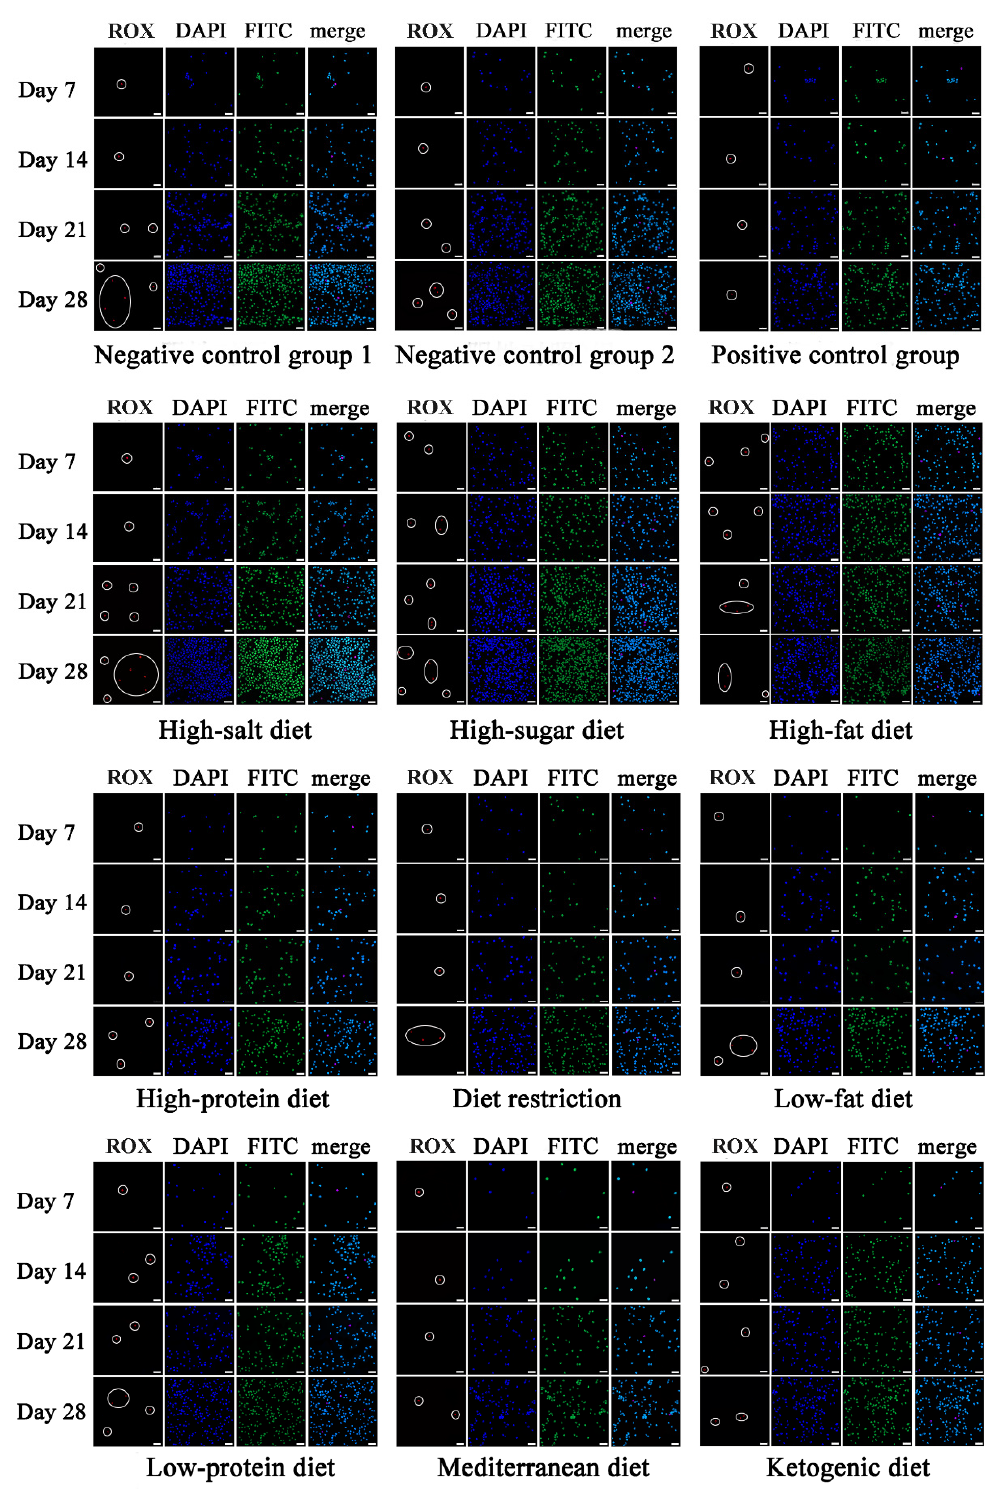
Figure 4. Fluorescent images of CTCs captured in vivo for different dietary patterns. CTCs were marked by circle (scale was 25 µ m). ROX, acceptor fluorophore (red).